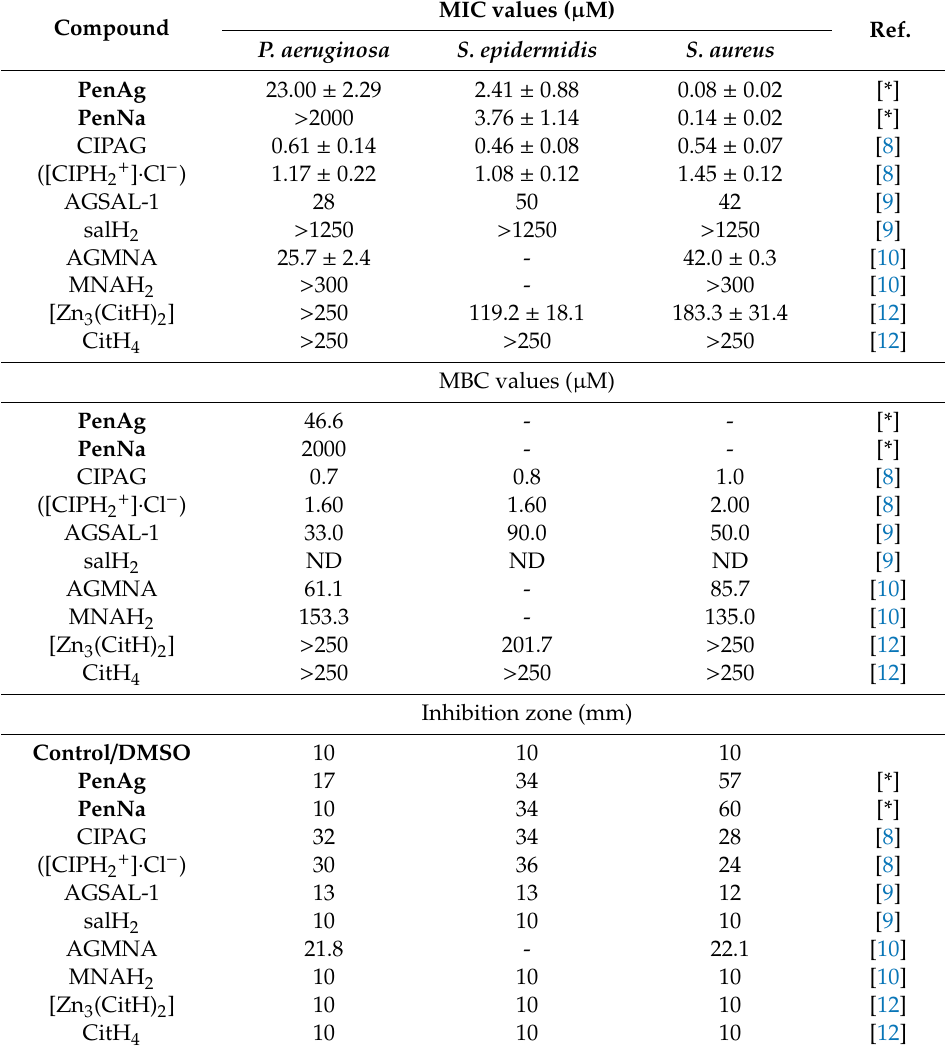
Table 2. Minimum inhibitory concentration (MIC), minimum bactericidal concentration (MBC), and inhibition zones (IZ) of PenAg and PenNa in comparison with the corresponding ones of other silver and zinc complexes tested against P. aeruginosa , S. epidermidis, and S. aureus